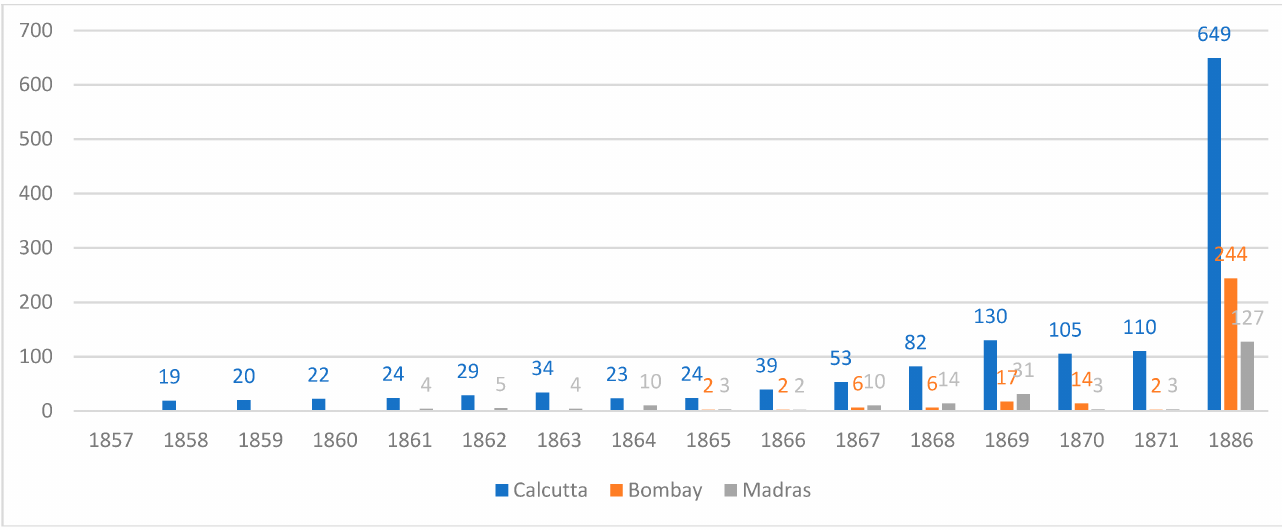
Figure 2. Number of students enrolled in law examinations by universities, 1857–1886. This figure presents the number of students taking the examinations for the degrees of Bachelor and Honors in Laws by universities, i.e., Calcutta